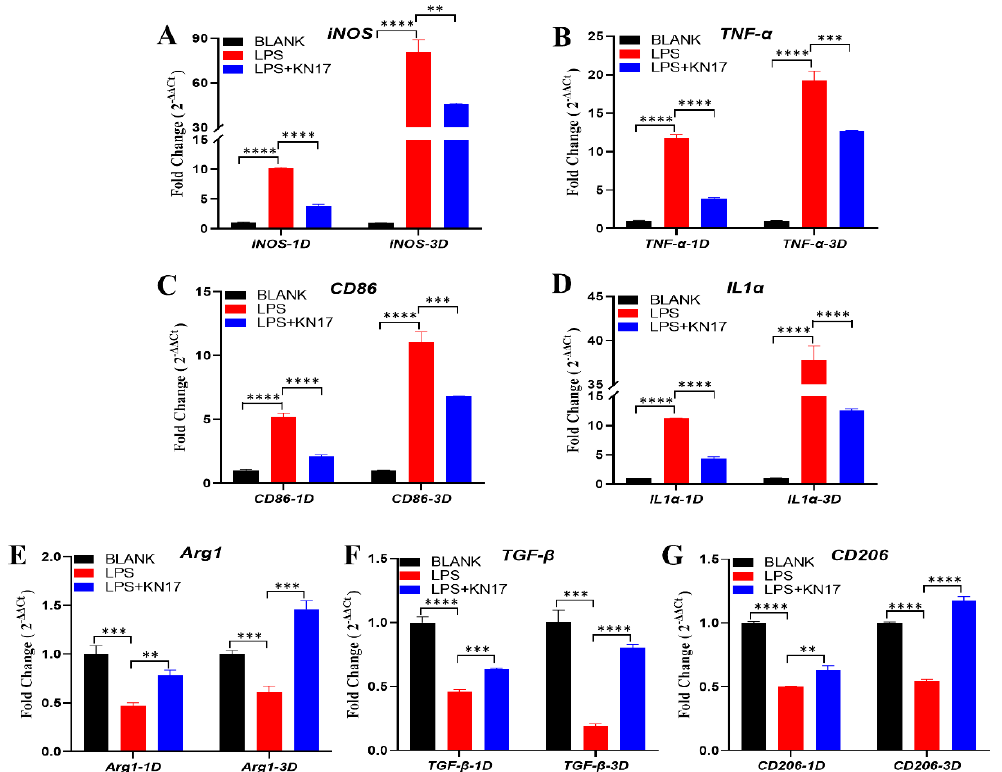
Figure 8. Under the conditions of LPS-induced inflammation, KN-17 was added to culture RAW 264.7 cells for day 1 and day 3, respectively, and the changes in the expressions of inflammation-related genes were detected by qPCR. ( A – D ) The levels of expression of pro-inflammatory related genes. ( E – G ) The levels of anti-inflammatory related genes. Note: Data are presented as mean ± SD; n = 3. ** Indicates statistical significance between the LPS group and KN-17 group. (** p < 0.01, *** p < 0.001, and **** p < 0.0001, ANOVA).